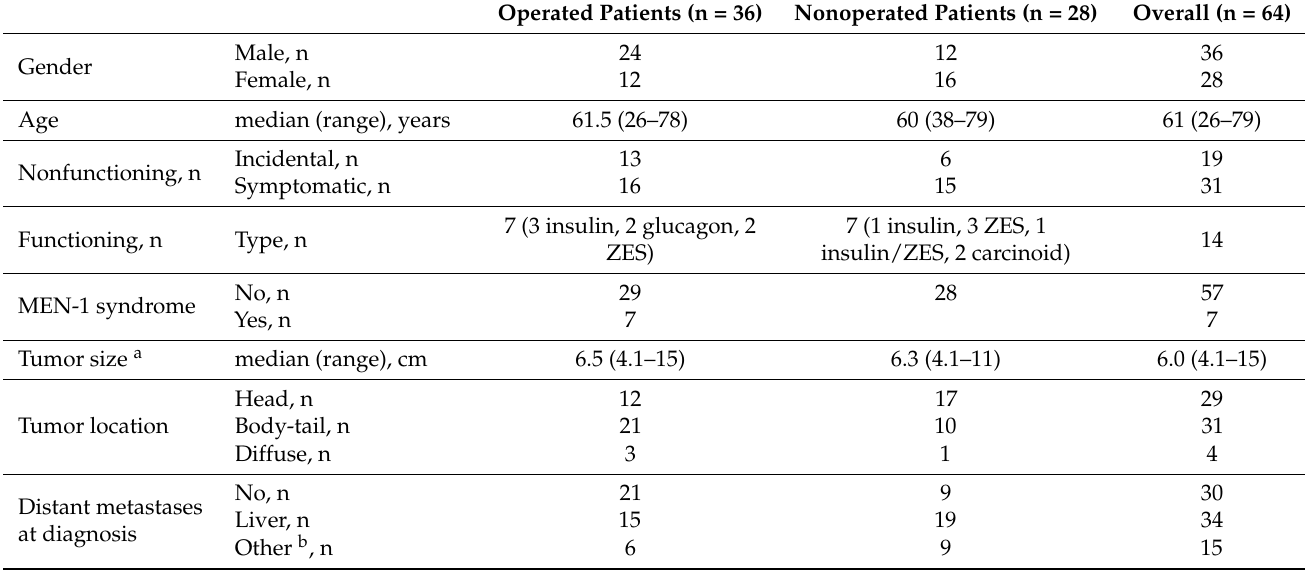
Table 1. Clinical history, pathological findings, and follow-up of operated (n = 36) and nonoperated (n = 28) patients with a pancreatic NEN > 4